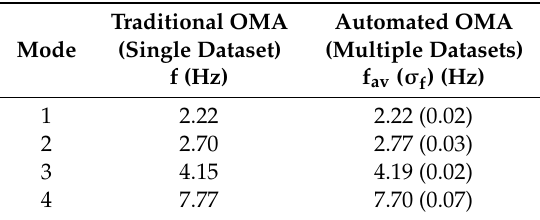
Figure 12. St. Francesco da Paola revolving bridge in Taranto ( a ), sample of the acceleration time histories (the early 30 min of the test) clearly showing the passage of heavy vehicles on the bridge—( b ), tracking of the fundamental frequencies ( c ). Table 8. St. Francesco da Paola revolving bridge: average value (f av ) and standard deviation ( σ f ) of the automatically identified natural frequencies in comparison with the result of traditional Operational Modal Analysis (OMA) applied to a sample dataset.